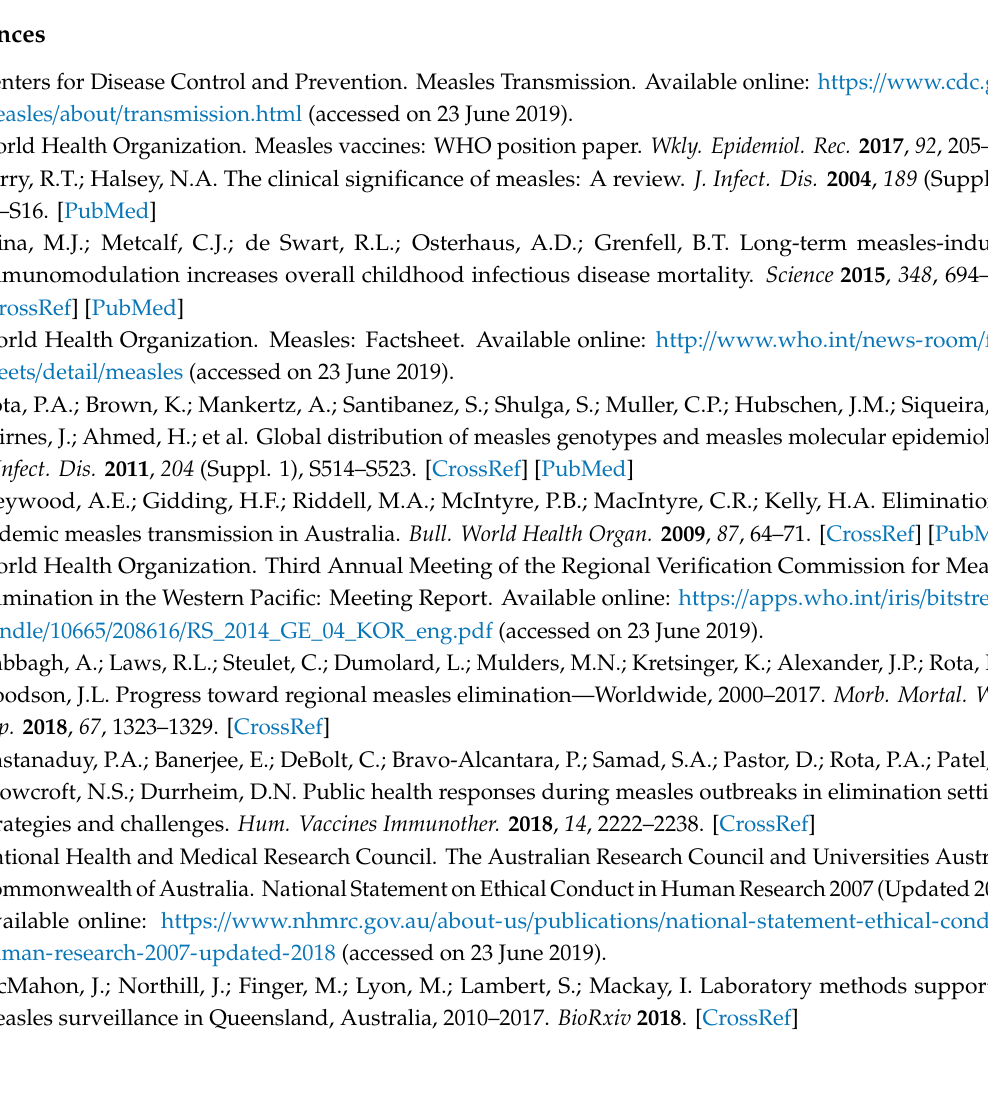
Figure S1: Phylogenetic analysis of MeV partial hemagglutinin (H) gene sequences, Figure S2: Phylogenetic analysis of MeV partial large gene (L) gene sequences, Table S1: Primers and probes for MeV RT-rPCR and